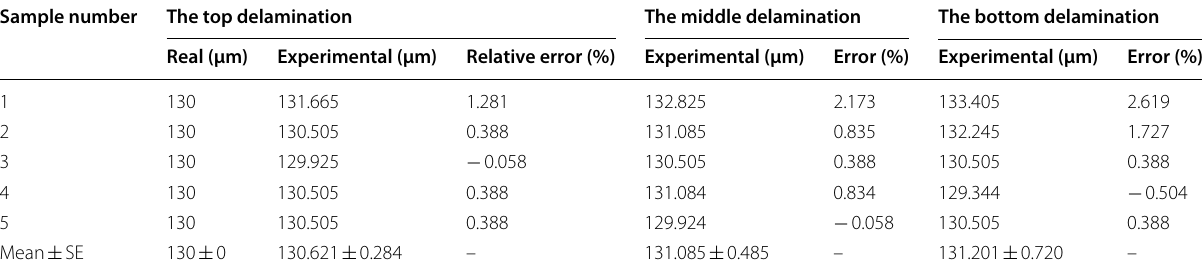
Note : The real thickness values here are the values measured by the micrometer while the experimental values designate the values measured by the THz-TDS